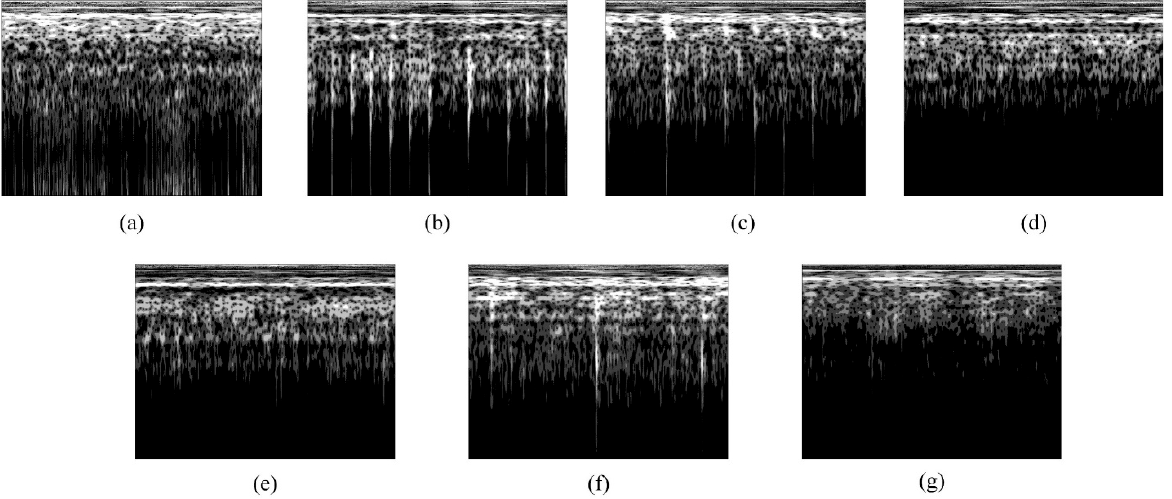
Figure 16. Threshold segmentation processing results for different types of fault signals under case A: ( a ) F1 fault; ( b ) F2 fault; ( c ) F3 fault; ( d ) F4 fault; ( e ) F5 fault; ( f ) F6 fault; and ( g ) F7 fault.